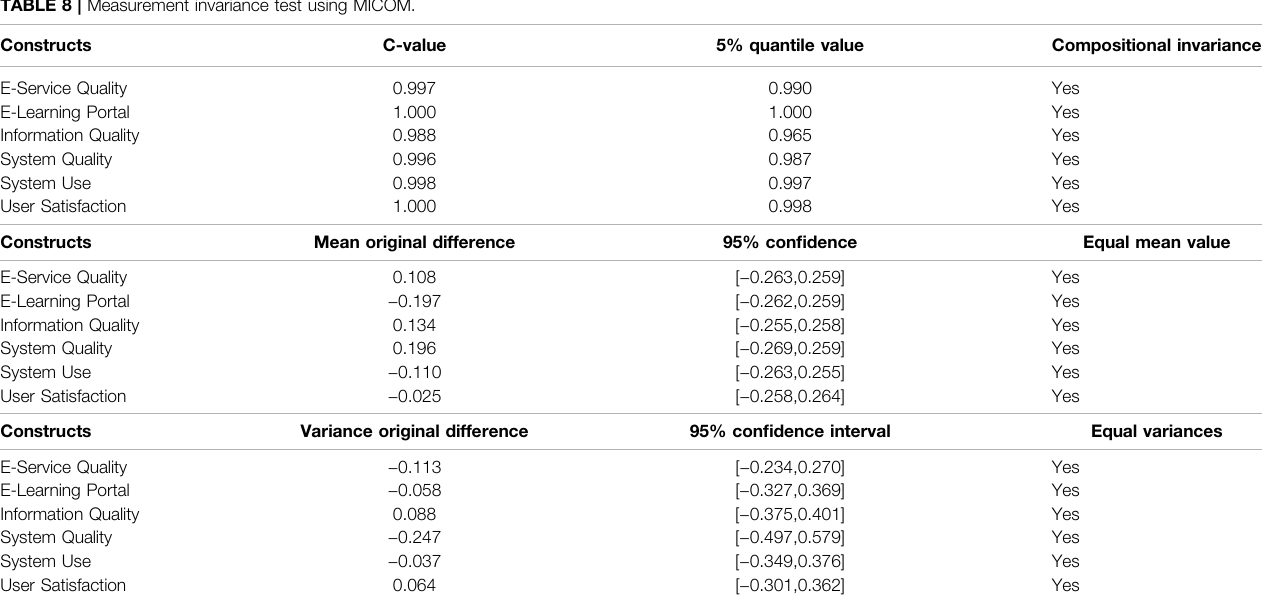
TABLE 8 | Measurement invariance test using MICOM.